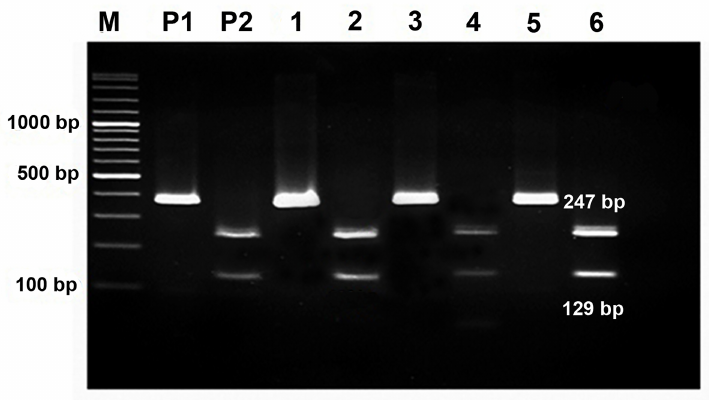
Fig 2. The PCR-RFLP products of O . viverrini after digestion with Fua I restriction enzyme. Amplicons of 247 bp and 129 bp from ITS2-PCR products of O . viverrini were generatedafter digestion. M was 100 bp DNA ladder, P1 was undigested positive and P2 was digested PCR products of positive samples. Numbers 1–6 showedundigested and digestedITS2-PCR products from fecal